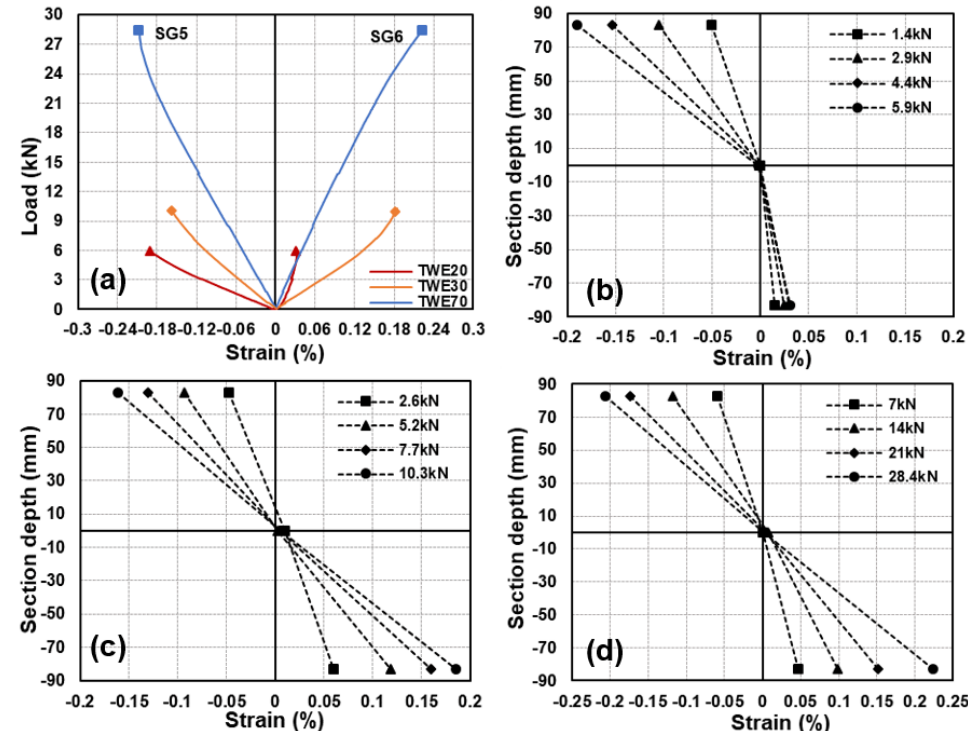
Figure 10. Strain responses at section B. ( a ) Load – strain responses for TWE specimens; ( b ) strain distribution along depth for TWE20; ( c ) strain distribution along depth for TWE30; and ( d ) strain distribution along depth for TWE70.